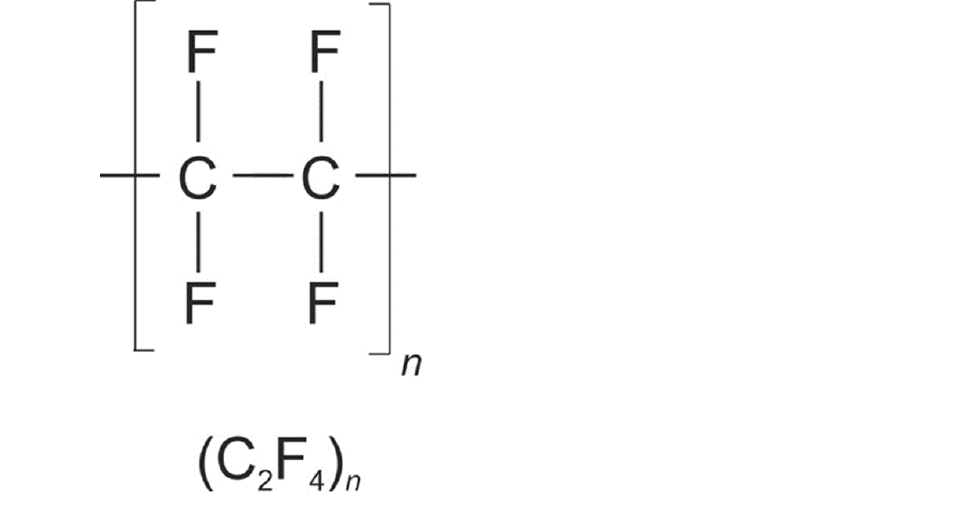
Figure 8. Chemical structure and sum formula of polytetrafluoroethylene (PTFE).